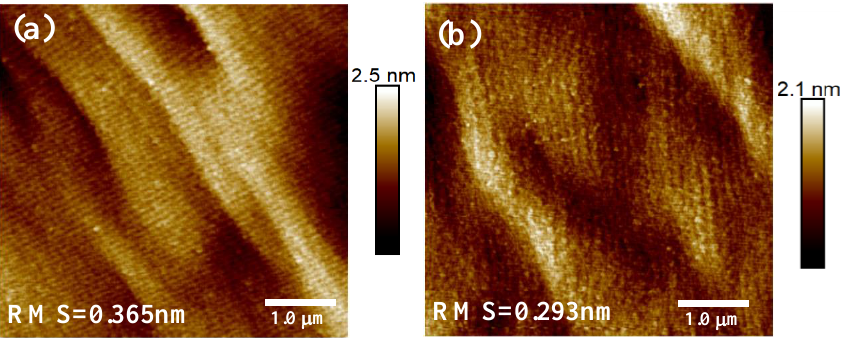
Figure 2. 5 × 5 µ m 2 AFM images for samples. The surface morphologies of ( a ) Sample S 0 and Figure 2. 5 × 5 μm 2 AFM images for samples. The surface morphologies of ( a ) Sample S 0 and ( b ) ( b ) Sample S 1 Sample S 1 .